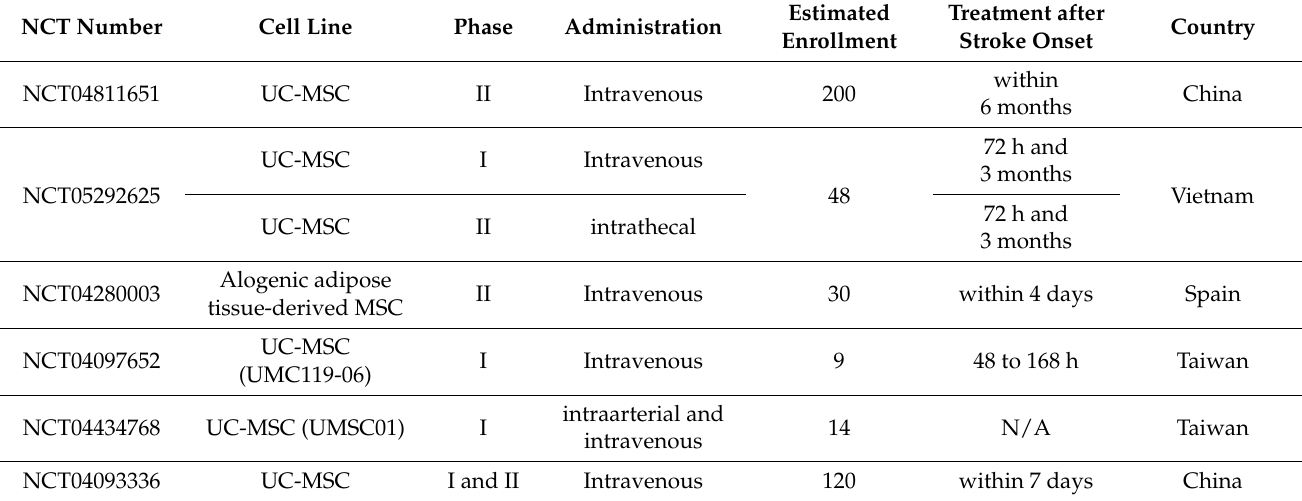
Table 3. Overview of ongoing (recruiting) clinical trials investigating stem-cell-based therapies in ischemic stroke patients. Abbreviations: N/A: not available; UC-MSC = umbilical cord-derived mesenchymal stem